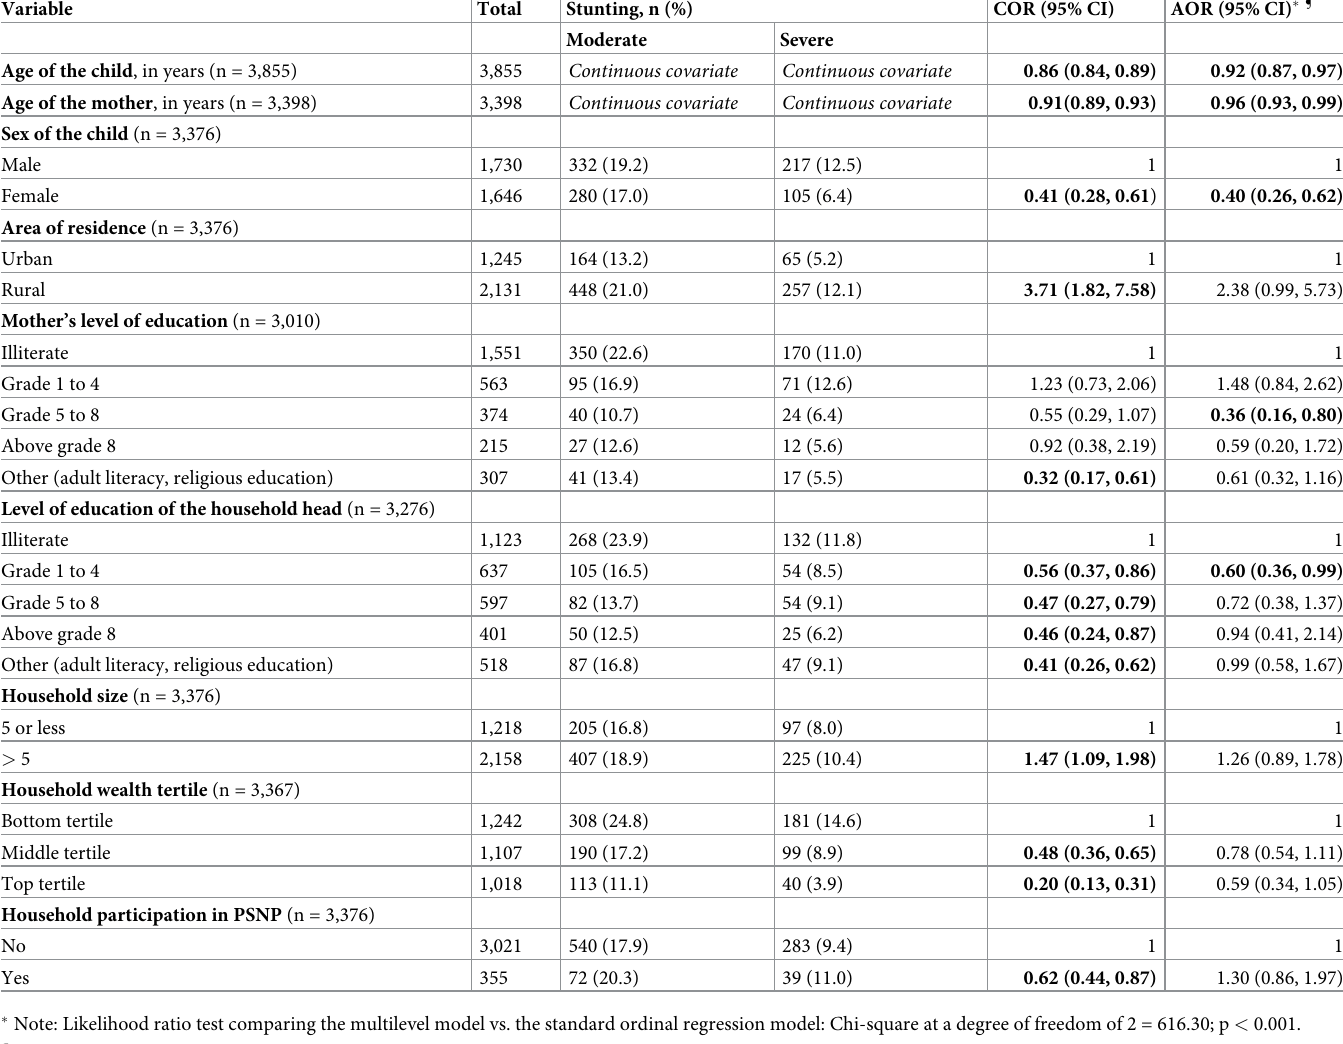
Table 5. Determinants of stunting in the older cohort, Ethiopia,